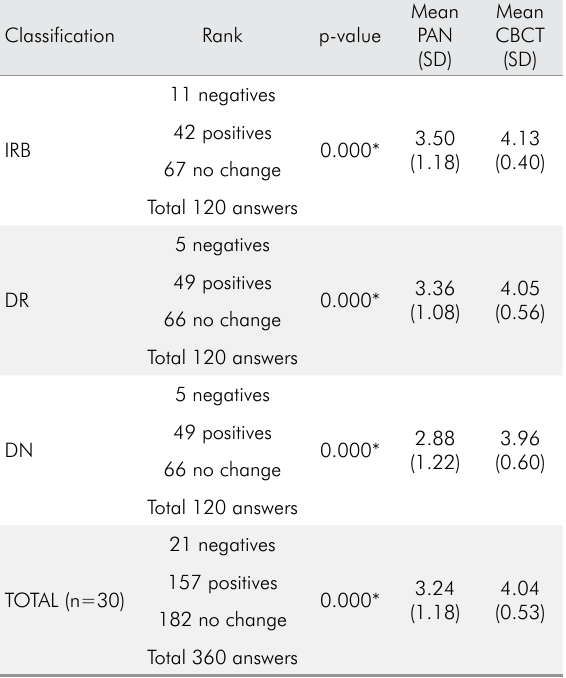
Table 4. Score ranking for the question “How confident are you to conduct surgery using this imaging exam?” A negative rank indicates the confidence score was higher when the panoramic exam was available, while a positive rank indicates higher diagnostic confidence scores after